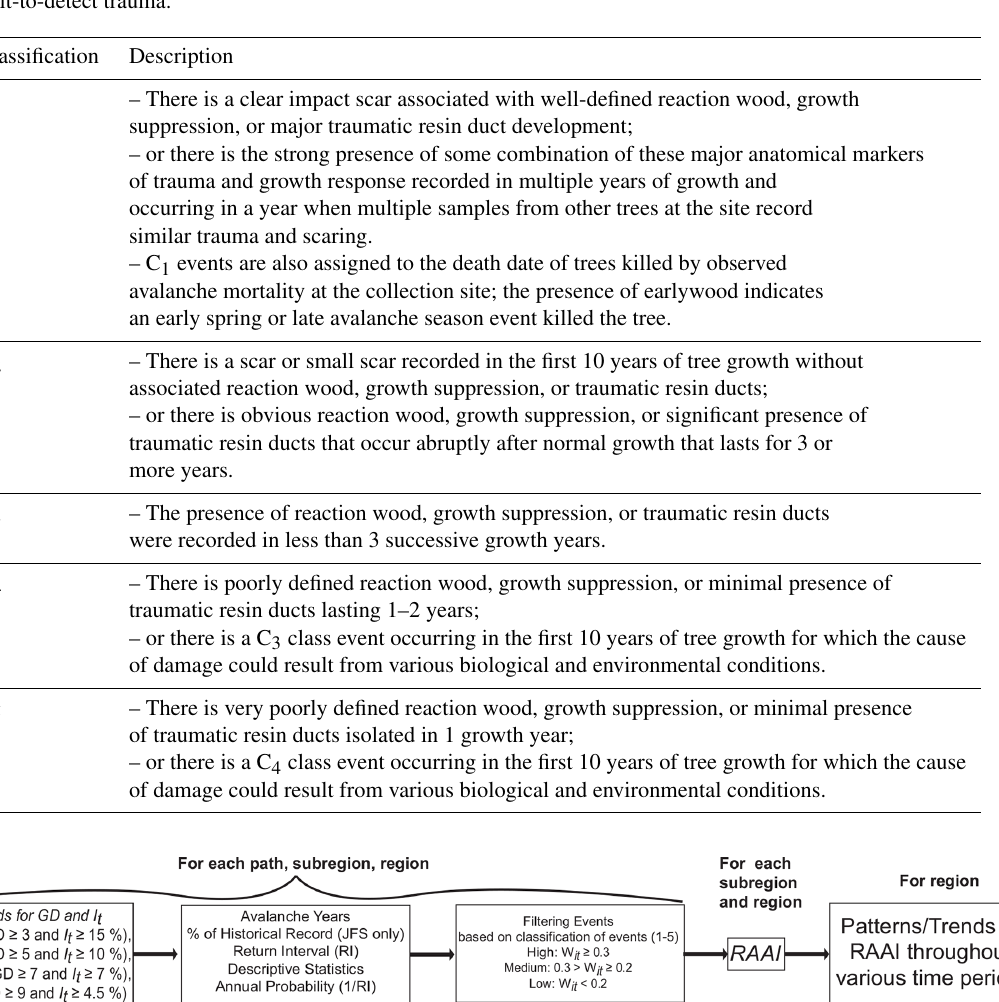
Table 2. Avalanche impact trauma classification ratings for which C1 represents the strongest and easily detectable trauma and C5 represents subtle and difficult-to-detect trauma.